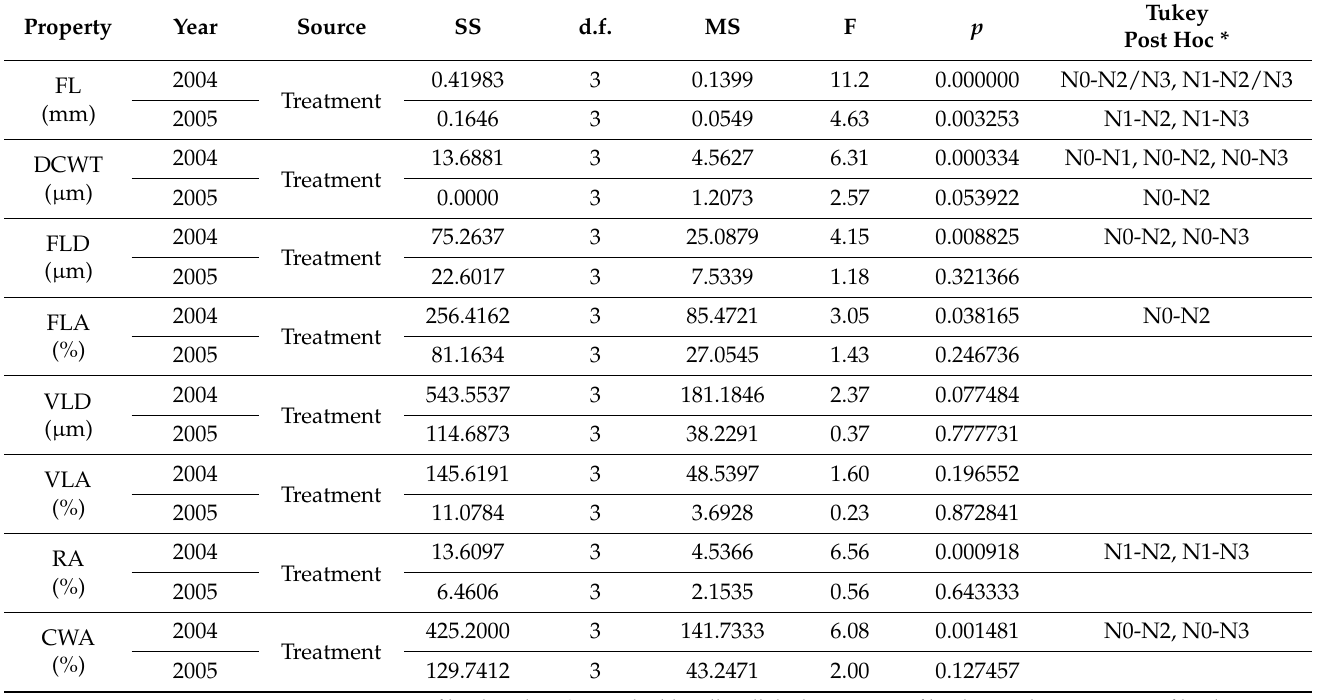
Table 3. Results of repeated measures analysis of variance ANOVA for the anatomical properties of the juvenile wood of the clone ‘Villafranca’ in two years (2004 and 2005) during nitrogen fertilisation.